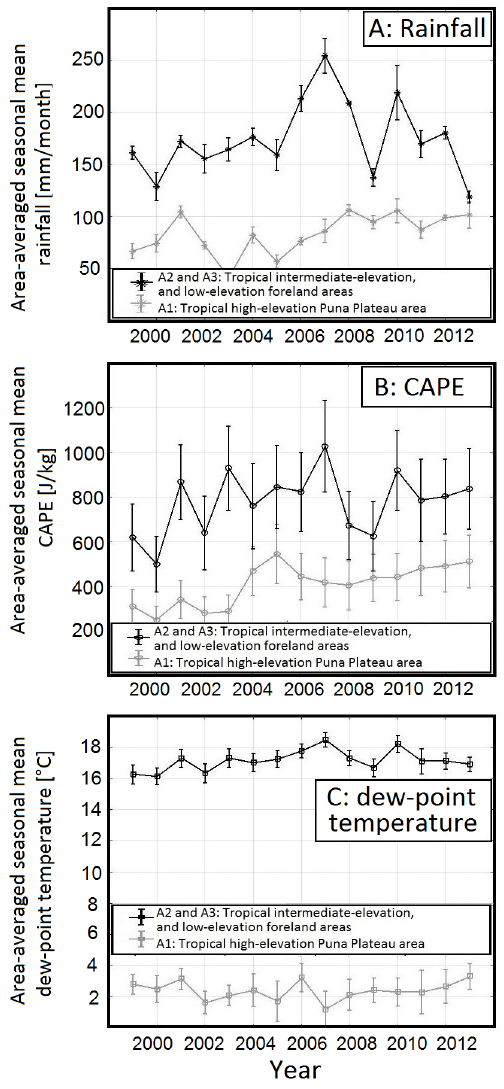
Figure 8. The spatial (area averaged A3 and A2 (black) compared to area averaged A1 (gray)) and temporal (DJF seasonal mean 1999 to 2013) pattern of dew-point temperature and CAPE along our study boxes in conjunction with rainfall. ( A ) Area-averaged DJF seasonal mean rainfall, ( B ) area-averaged DJF seasonal mean CAPE, and ( C ) area-averaged DJF seasonal mean dew-point temperature are represented in these